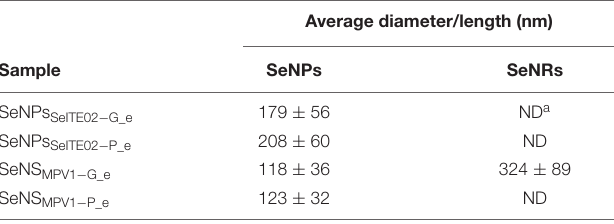
TABLE 1 | Average diameter and length (nm) of SeNS generated by SeITE02 and MPV1 cells grown for 120-h in the presence of SeO 2 − 3 and either glucose or pyruvate as the only source of carbon and